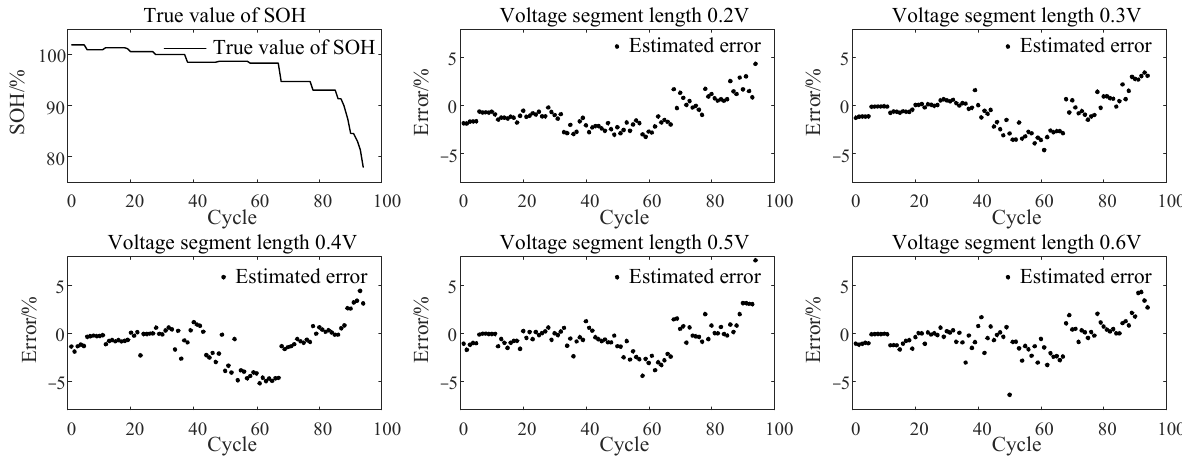
Figure 10. SOH estimation results under 10 A discharge.